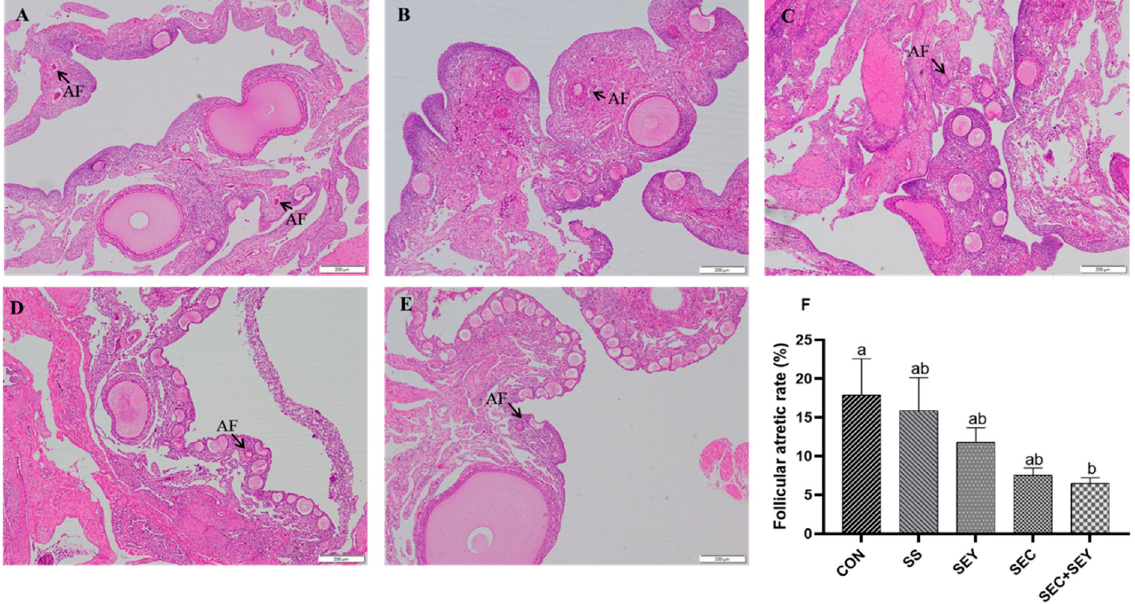
Figure 1. Effects of different Se sources on the histology of ovary in laying hens. ( A – E ) H&E staining of the ovaries. ( A ) the CON group; ( B ) the SS group; ( C ) the SEY group, ( D ) the SEC group, and ( E ) the SEC + SEY group. Scale bar = 200 µ m. AF, atresia follicle. ( F ) Effects of different Se sources on follicular atretic rate. Data are means of 6 replicates per dietary treatment. Bars with different letters (a,b) indicate a significant difference ( p < 0.05).